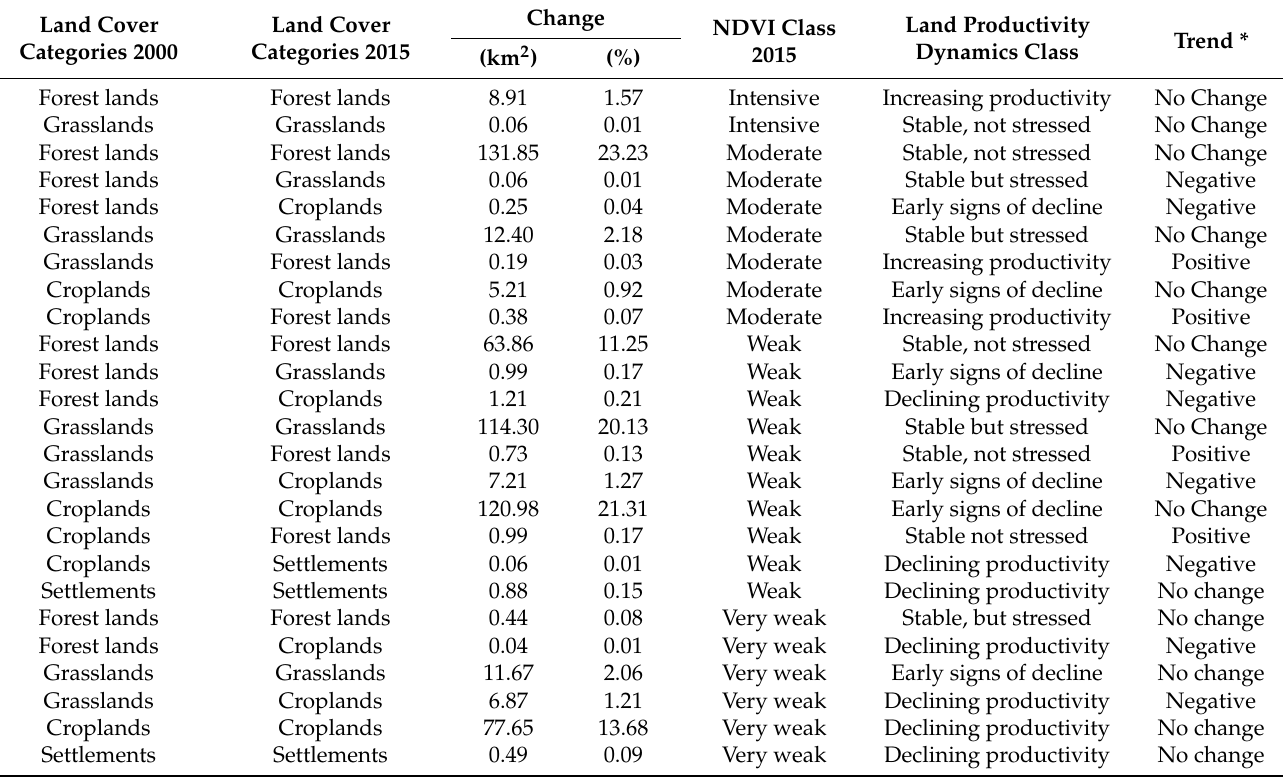
Table 4. Land Cover changes and NDVI classes between 2000 and 2015 for LPD (Land Productivity Dynamics) in Ixtacamaxtitlan, Puebla,